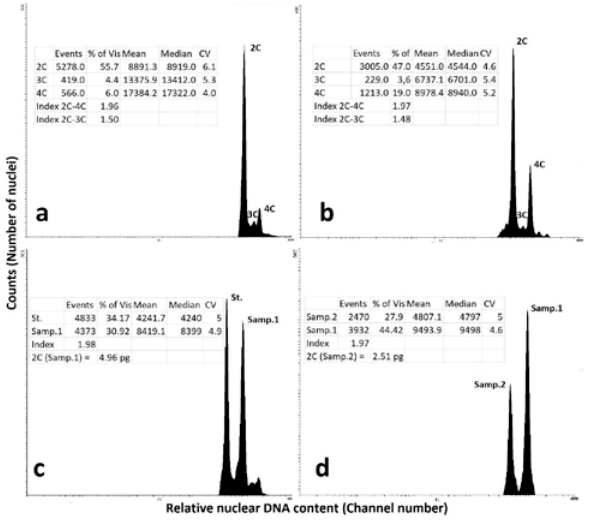
Figure 4. Flow cytometry histograms: a – Agrimonia pilosa (Tomsk, Russia); b – Agrimonia pilosa (Beijing, China); c – Agrimonia pilosa (Tomsk, Russia), Samp. 1 with internal standard ( Glycine max (L.) Merr.), St.; d – Agrimonia pilosa (Tomsk, Russia), Samp. 1 with